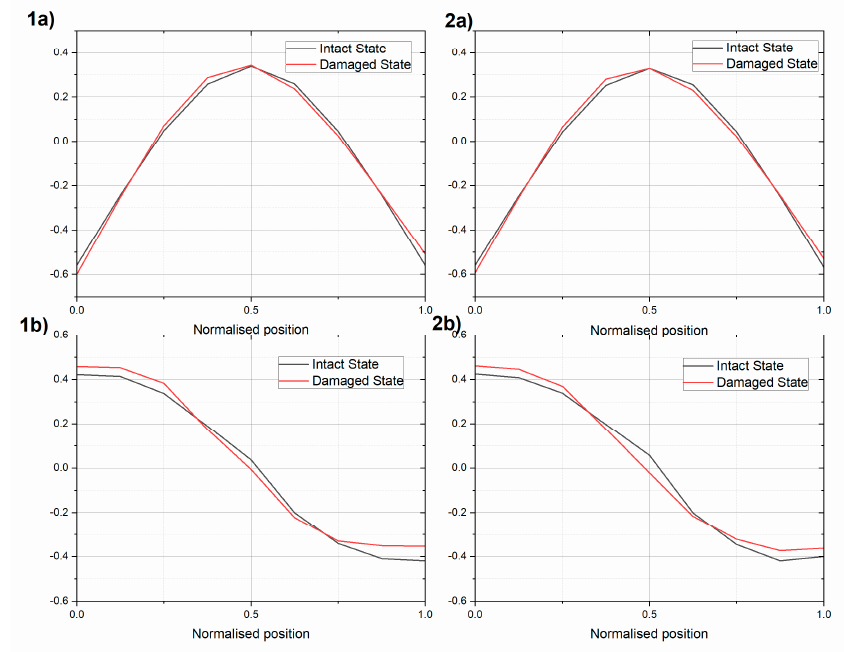
Figure 11. Comparison of the first ( a ) translational and ( b ) rotational modes of the intact and damaged (1) beam UHPC1_L and (2) beam UHPC2_L.